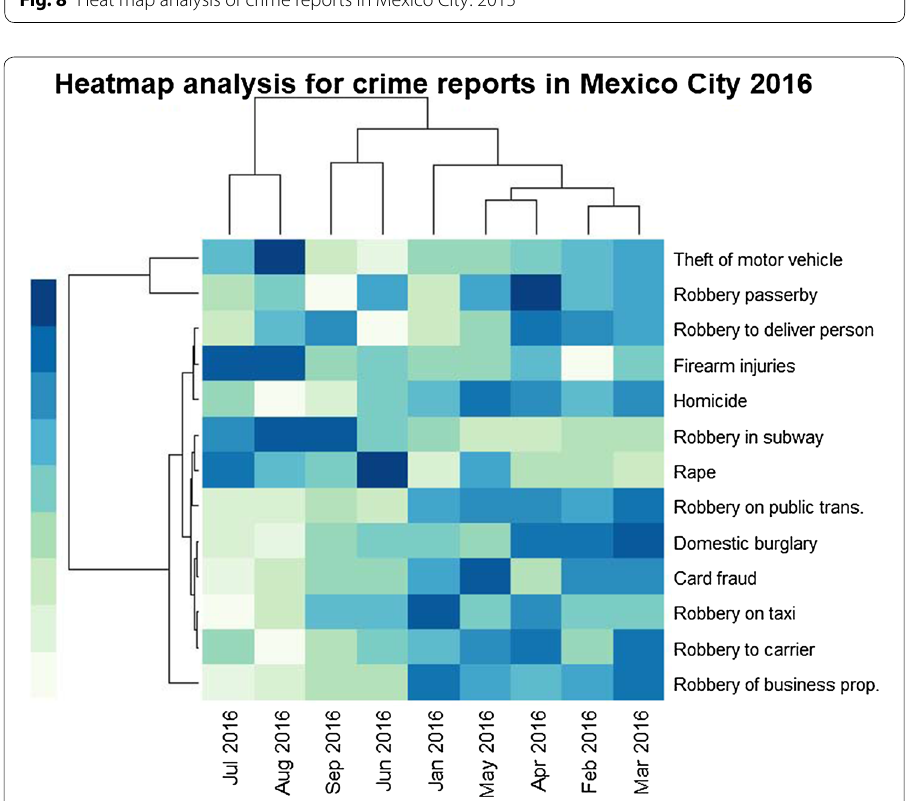
Fig. 8 Heat map analysis of crime reports in Mexico City: 2015